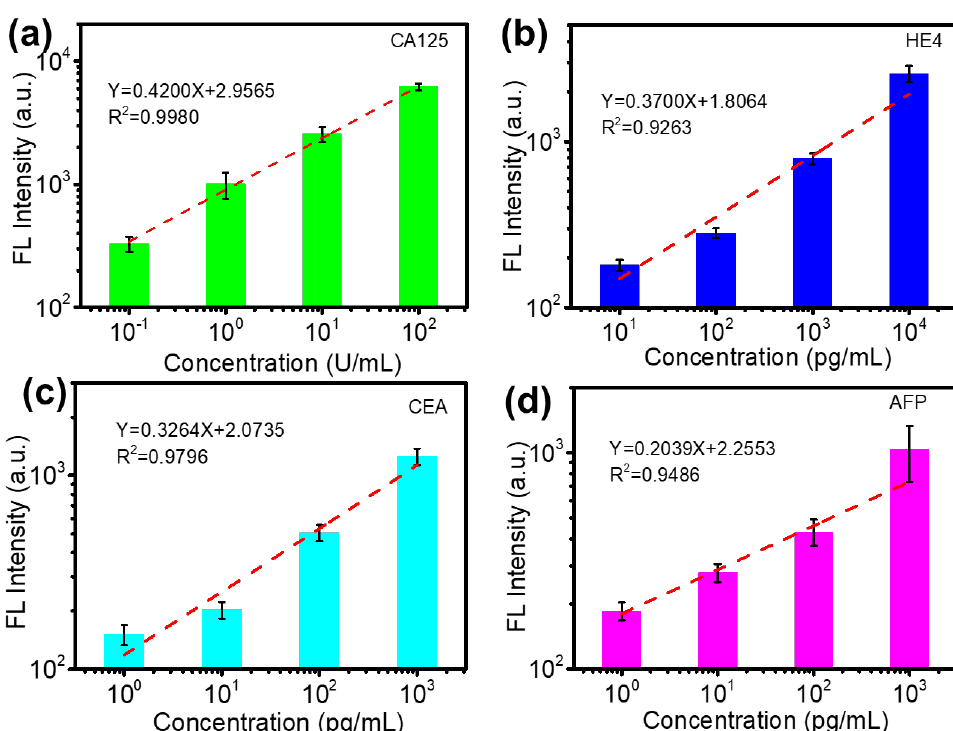
Figure 3. The relationship between detected fluorescence intensity and concentrations of ( a ) CA125, ( b ) HE4, ( c ) CEA and ( d ) AFP in the samples. The dotted lines are the simulated linear curves based on the detected signals; The error bars are from three different tests.